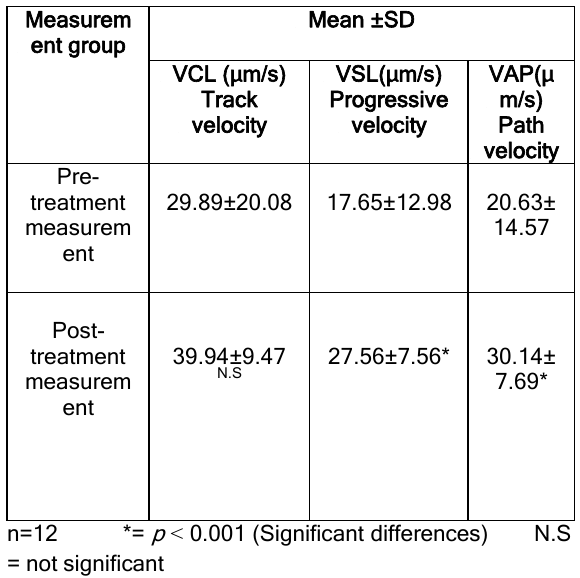
Table 5: The pre-post values of sperm tracks and velocities (CASA dynamic parameter analysis report